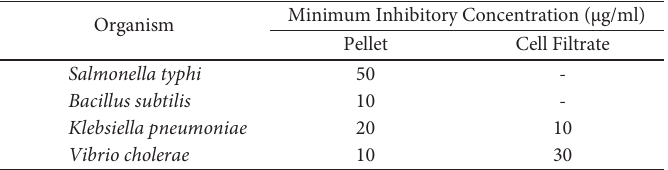
Table 3. Minimum Inhibitory Concentration of Silver nanoparticles synthesized from Escherichia coli.